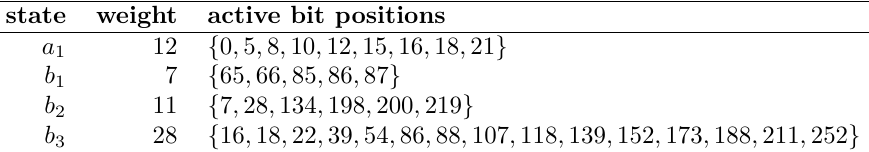
Table 7: 4-round differential trail with lowest weight we